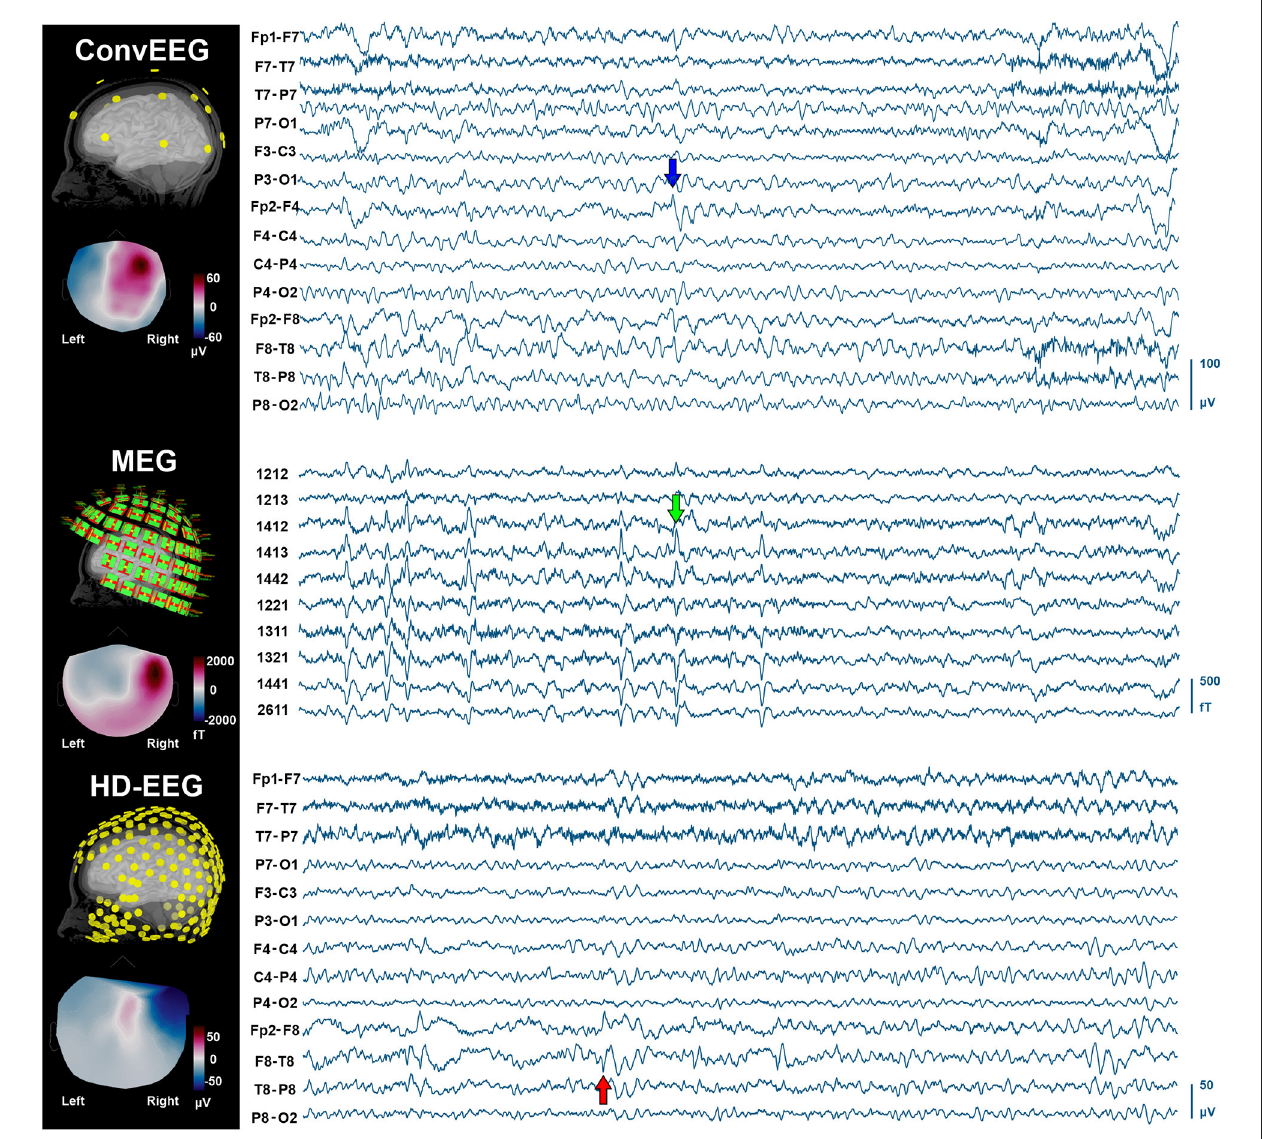
FIGURE 2 | IEDs on non-invasive neuroimaging modalities (conv-EEG, MEG, and HD-EEG). (Left) Location of sensors for each modality co-registered with the patient’s cortical surface reconstructed from the intra-operative MRI. Topographic maps at the peak of IEDs for each modality. (Right) Time-traces (10s) with frequent IEDs for all three non-invasive modalities. Displayed time-traces of MEG and conv-EEG are synchronous.